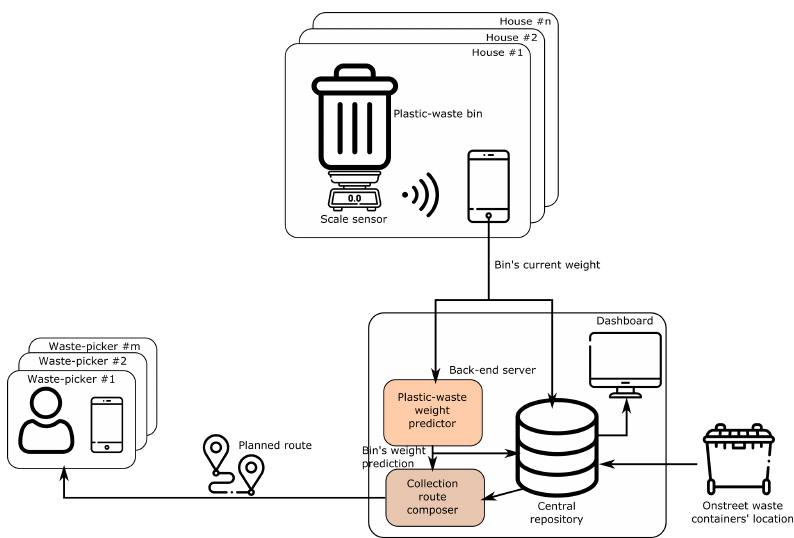
Figure 1. Overall architecture of the smart-collaborative waste-management